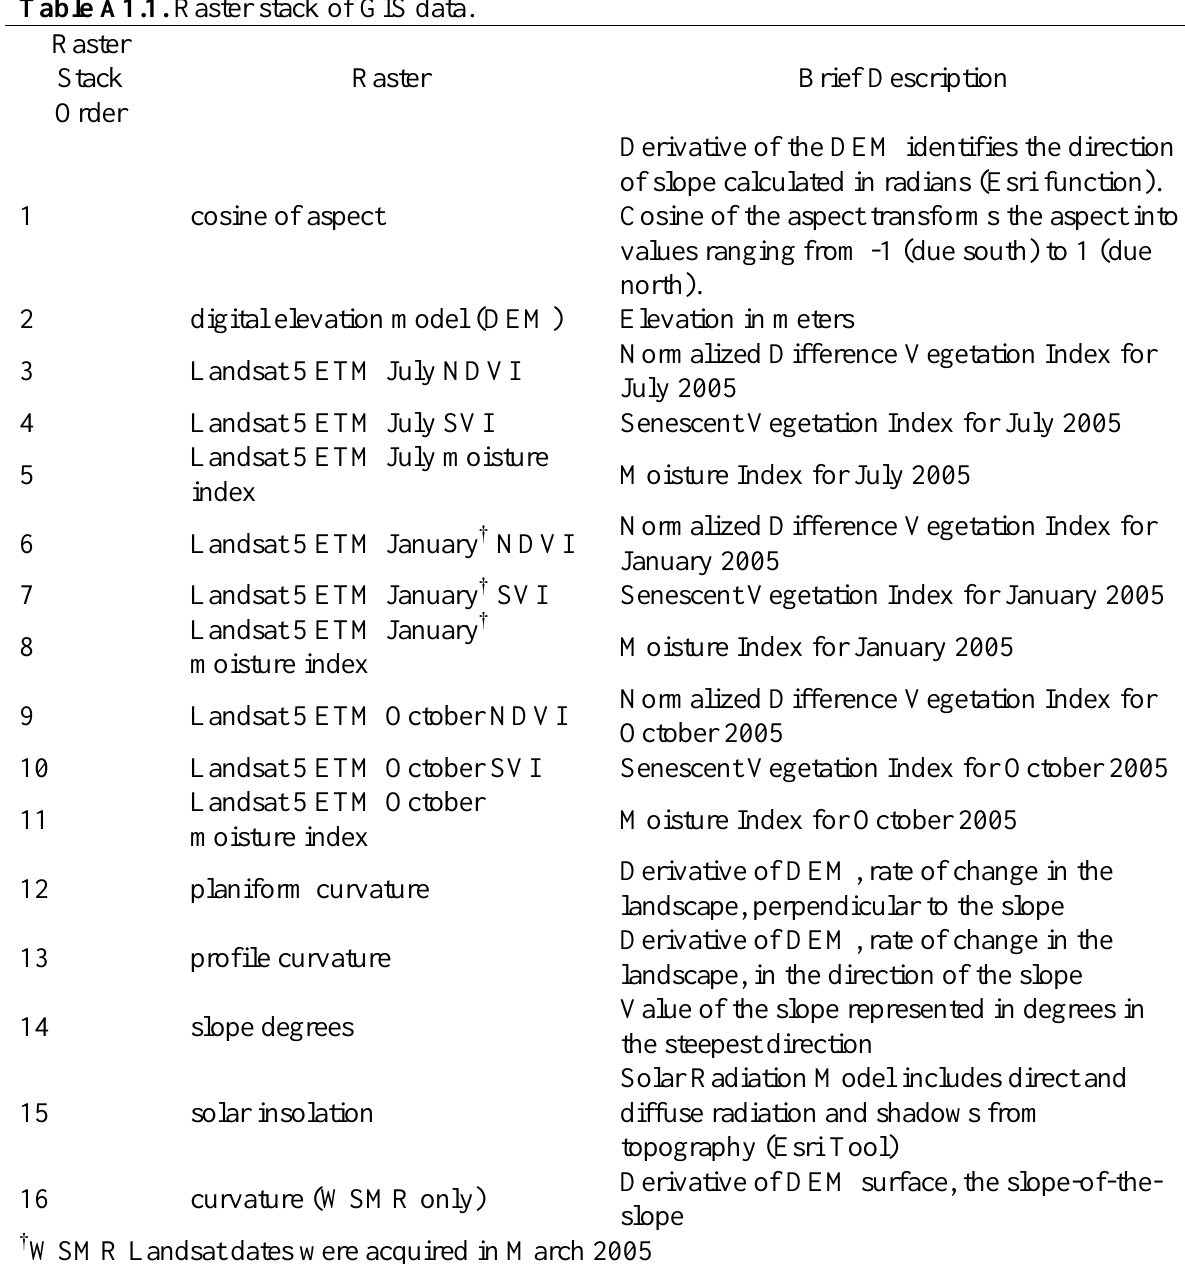
Table A1.1. Raster stack of GIS data.